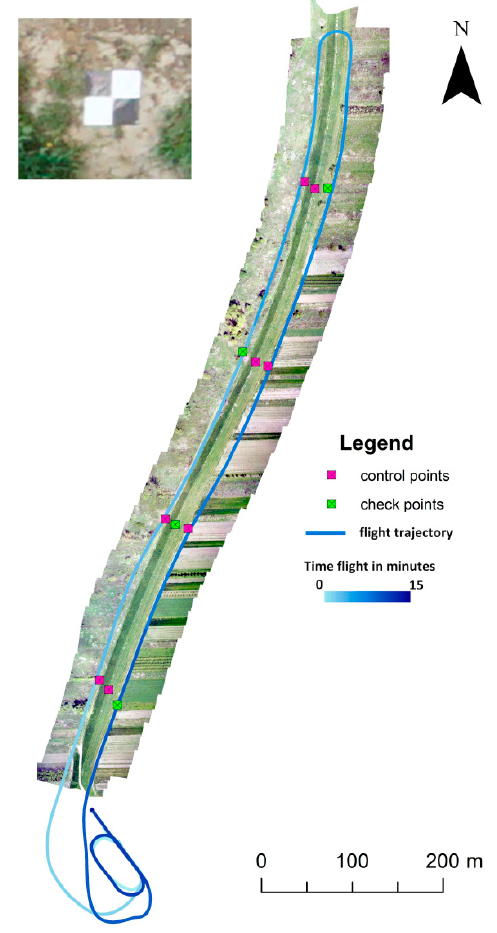
Figure 3. Visualization of the example flight trajectory, control and check points signalized with chess planes from one flight mission.